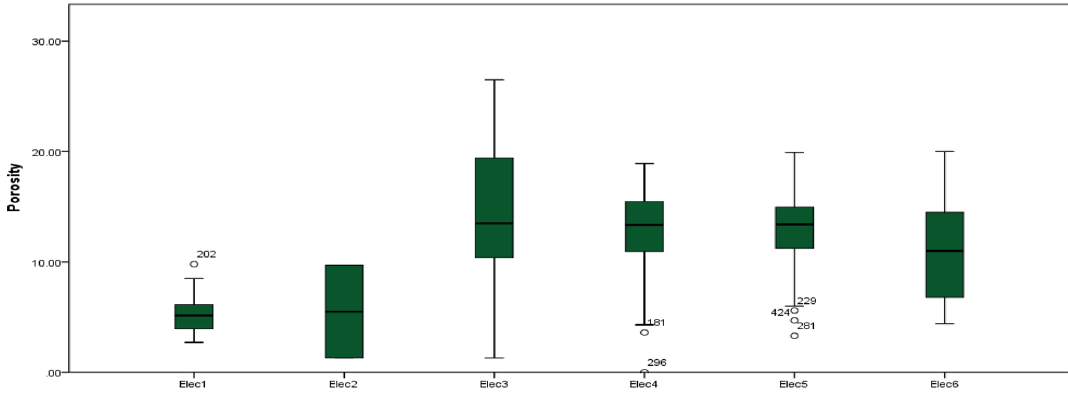
Fig. 5 Box plot of porosity in electrofacies